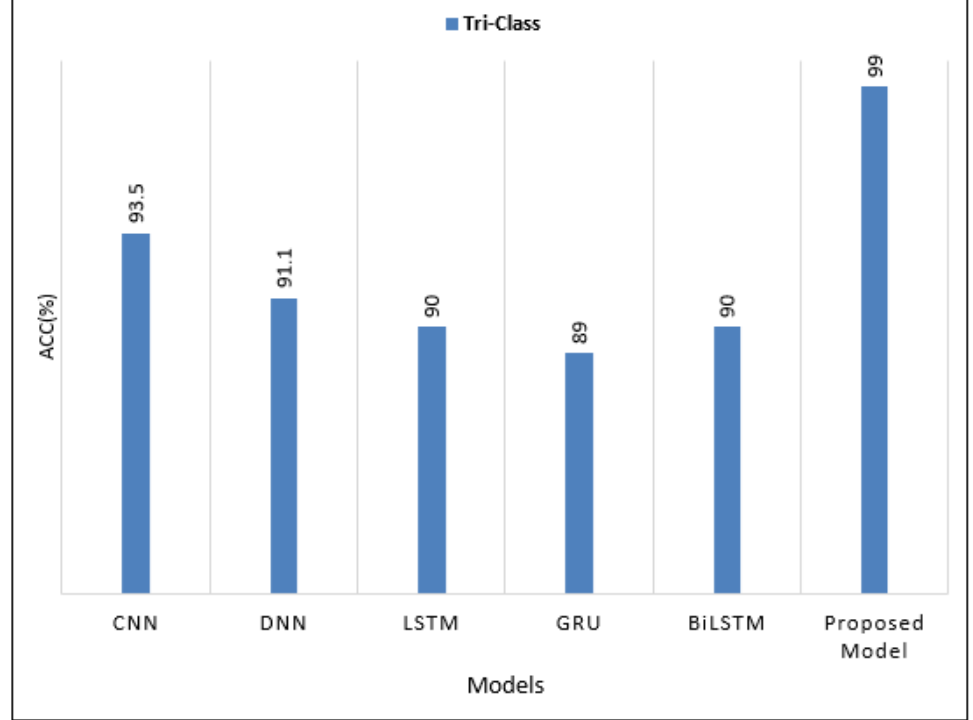
Figure 12. Comparing the attained results of the proposed CAD system for BT classification with state-of-art DL techniques.